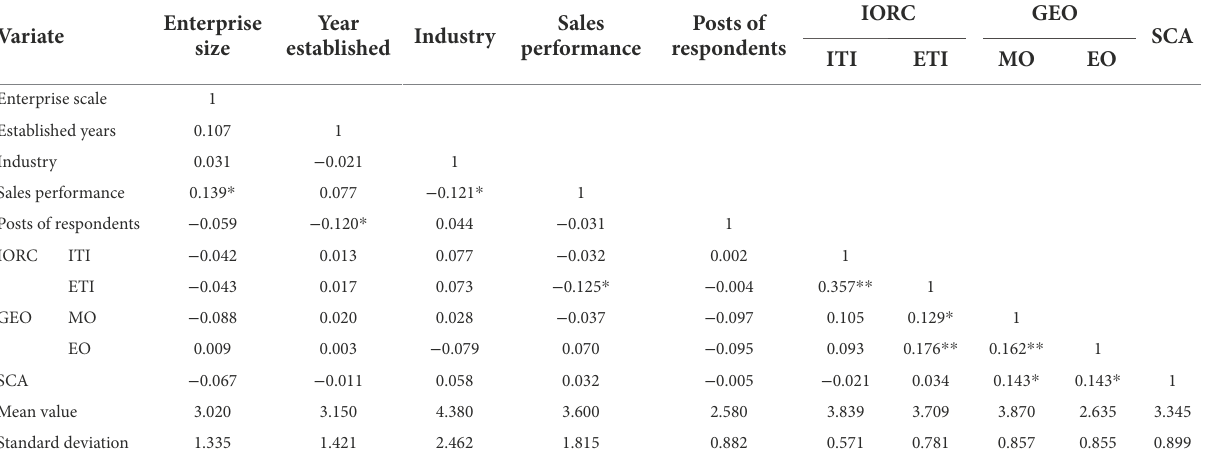
TABLE 4 Results of descriptive statistics and correlation.